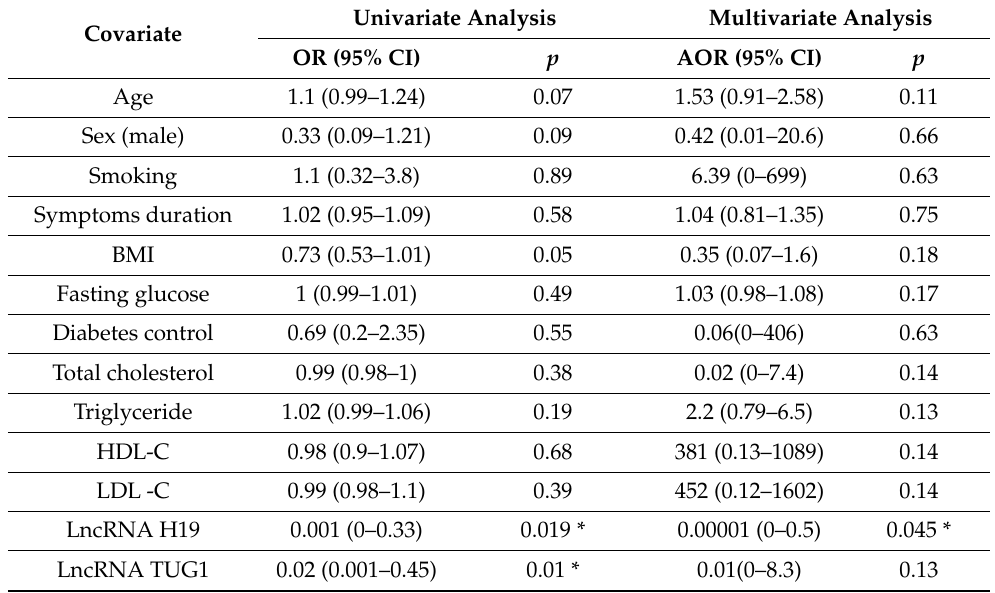
Table 4. Logistic regression analysis of risk factors for IBS